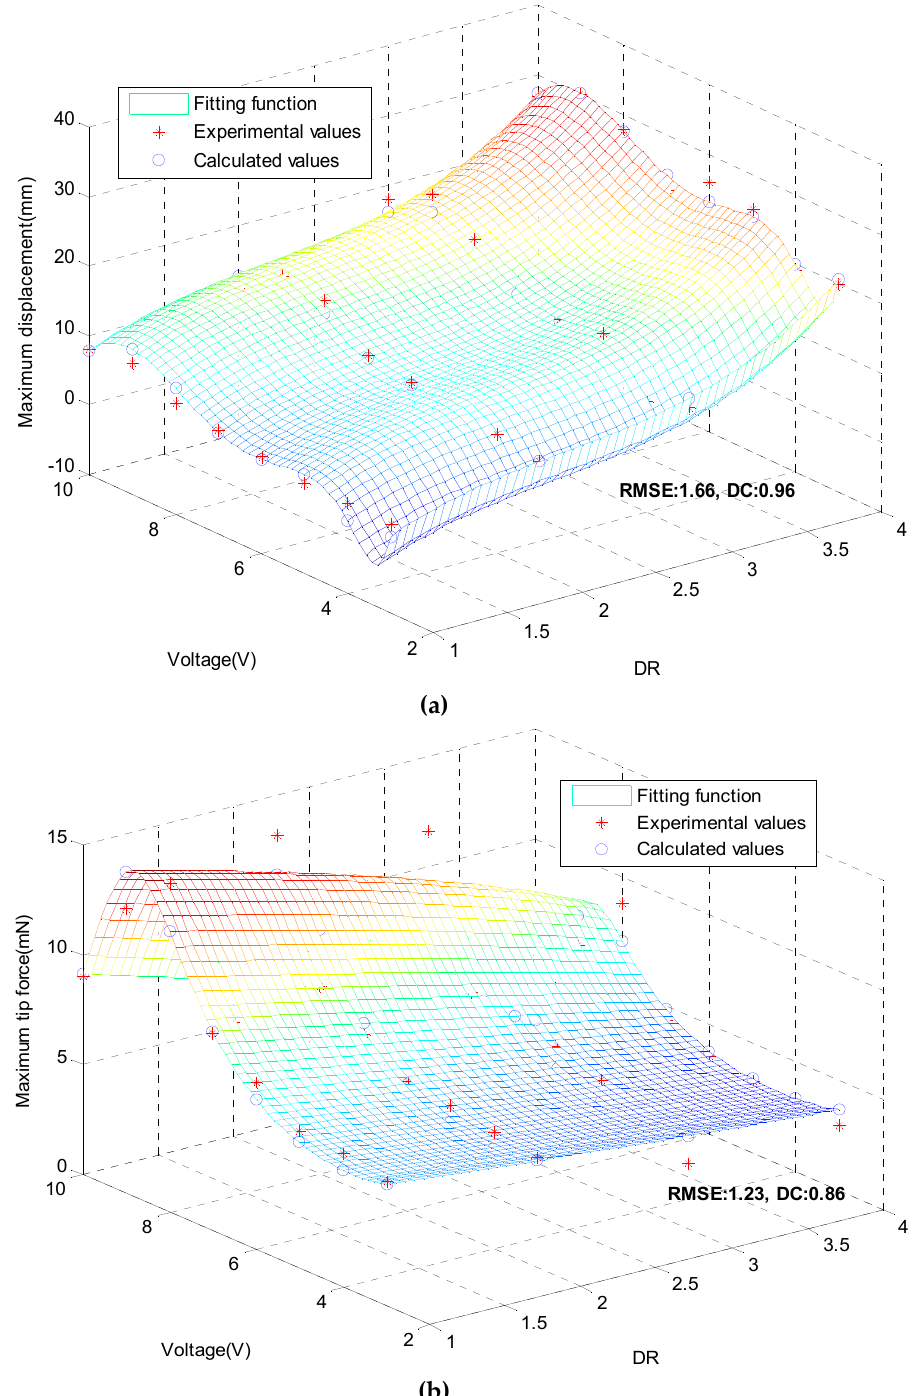
Figure 8. Comparison diagram of experimental and calculated values. ( a ) maximum displacements; ( b ) maximum tip force.